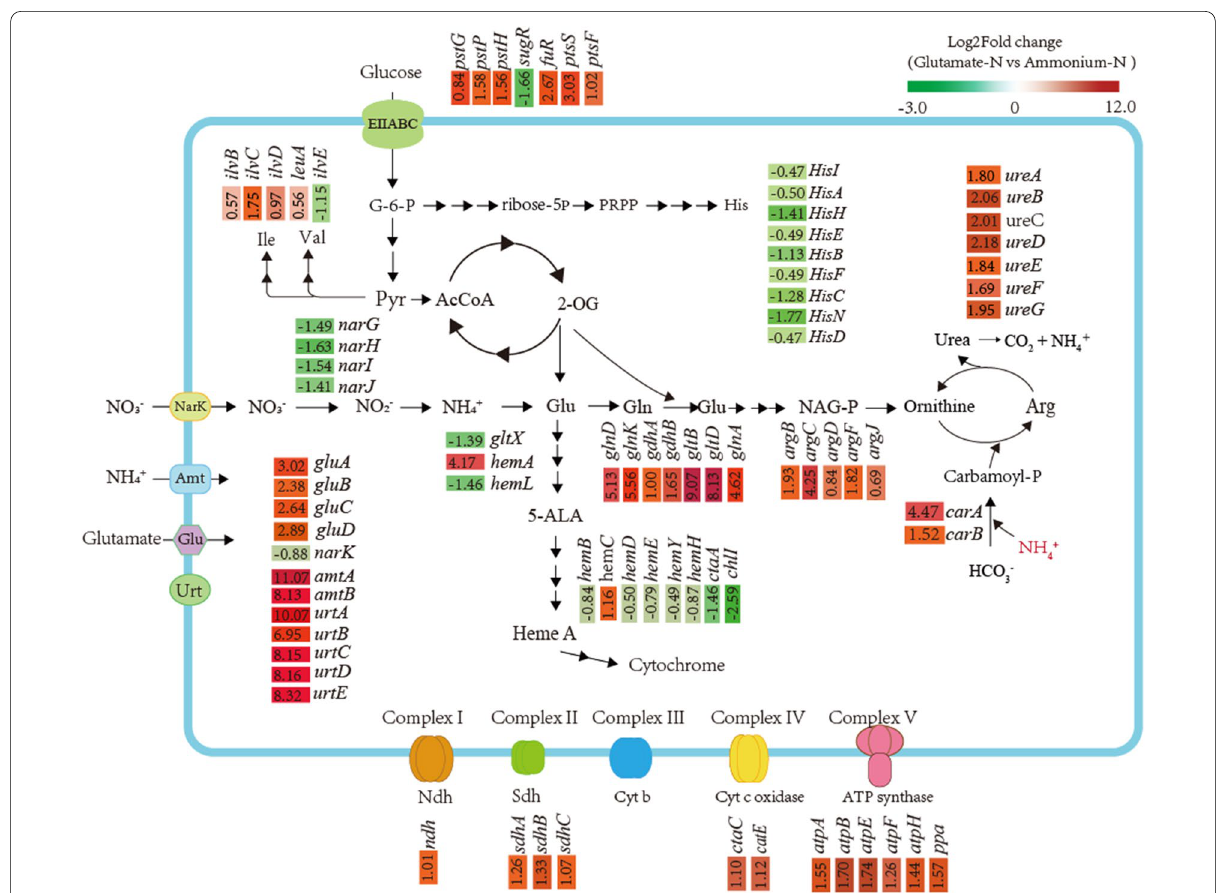
Fig. 3 The differentially expressed genes in different metabolic pathways when wild type strain was grown with glutamate instead of ammonium as sole nitrogen source. DEGs in different metabolic pathways are shown using heat maps with gene names. Metabolites and abbreviated according to 13CFLUX2 (www. 13Cfl ux. net) and description of all genes has been given in Additional file 1: Table S4. Red indicates upregulation. Blue indicates